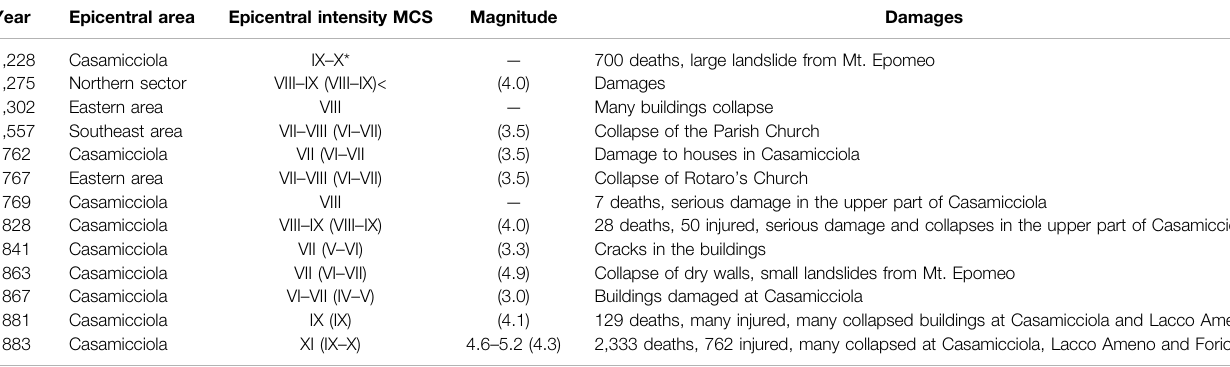
TABLE 1 | Historical seismicity in the island of Ischia as reported by Cubellis and Luongo,